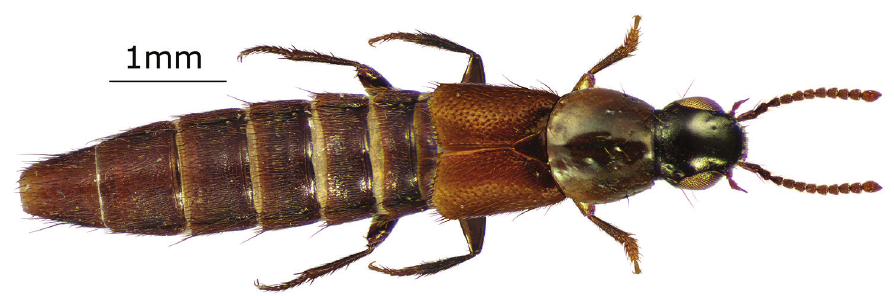
Figure 1. Dorsal habitus of Quedius spencei , sp. n.